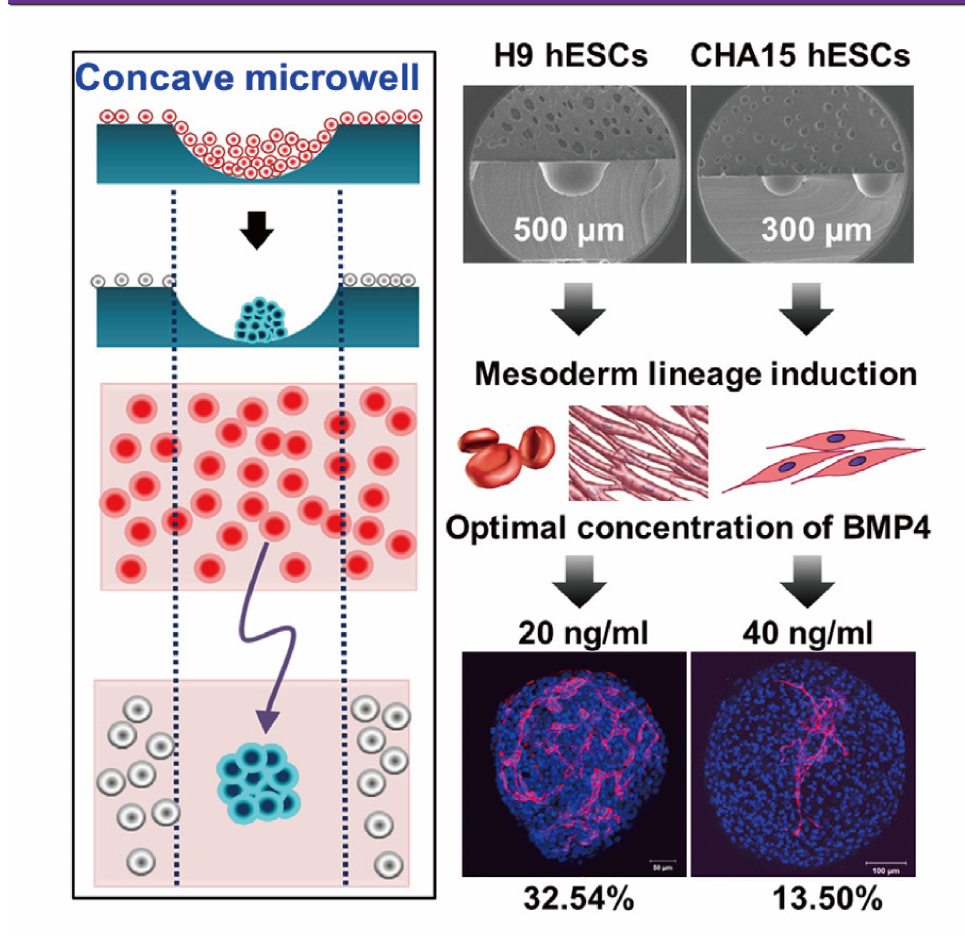
Figure 22. Formation of embryoid bodies and procedures of determination of optimal induction condition [48]. At first, hESCs were seeded into concave microwells to form embryoids. Then, these embryoids were treated by mesoderm inducer BMP4 after mesoderm lineage induction. Lastly, the distribution of platelet endothelial cell adhesion molecule (PECAM) was checked to evaluate the effect of